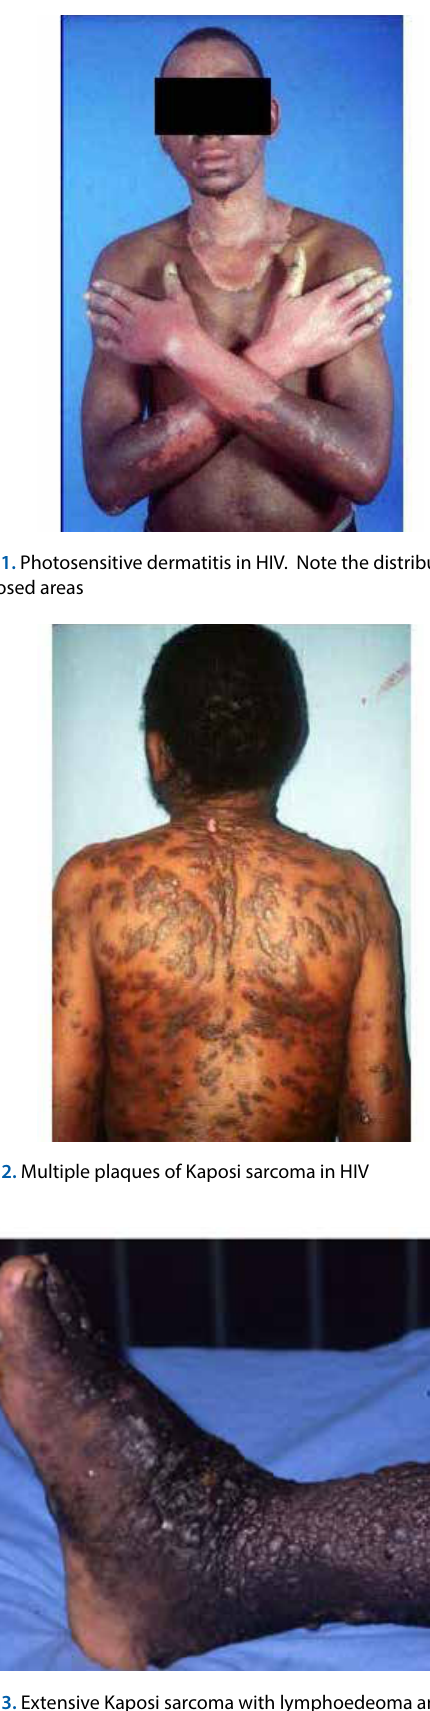
Figure 13. Extensive Kaposi sarcoma with lymphoedeoma and multiple